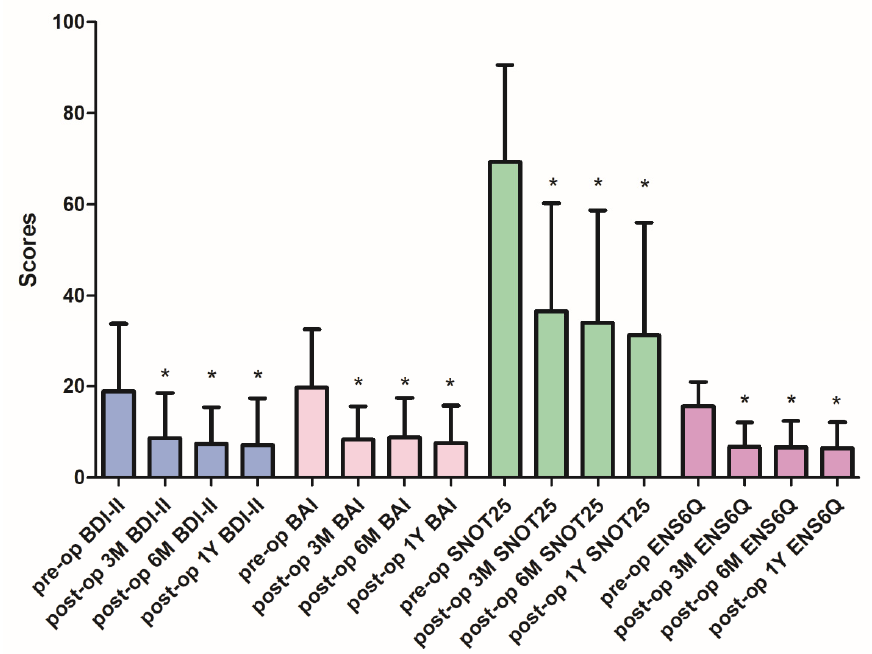
Figure 1. The subjective measurements before and after surgical treatment. The postoperative BDI ‐ II, BAI, ENS6Q and SNOT ‐ 25 scores significantly improved at the third month and remained plat